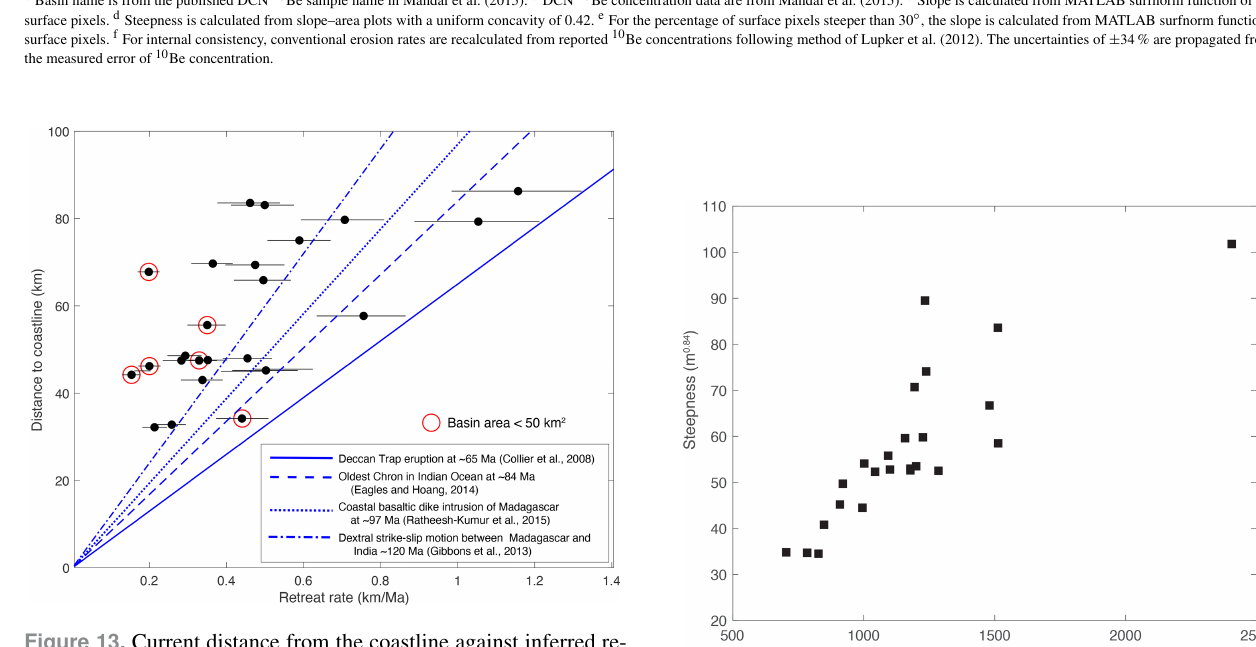
Figure 13. Current distance from the coastline against inferred re- treat rate of the Western Ghats escarpment basins from detrital 10 Be concentrations with 1 σ uncertainty. Retreat rates of the escarpment are calculated using the basin projection method with azimuth taken as N57E. See Table 2 for the data. Age of rifting is constrained by various events as indicated and is expected to be older than these constraints. Basins smaller than 50km 2 are indicated with open red circles.